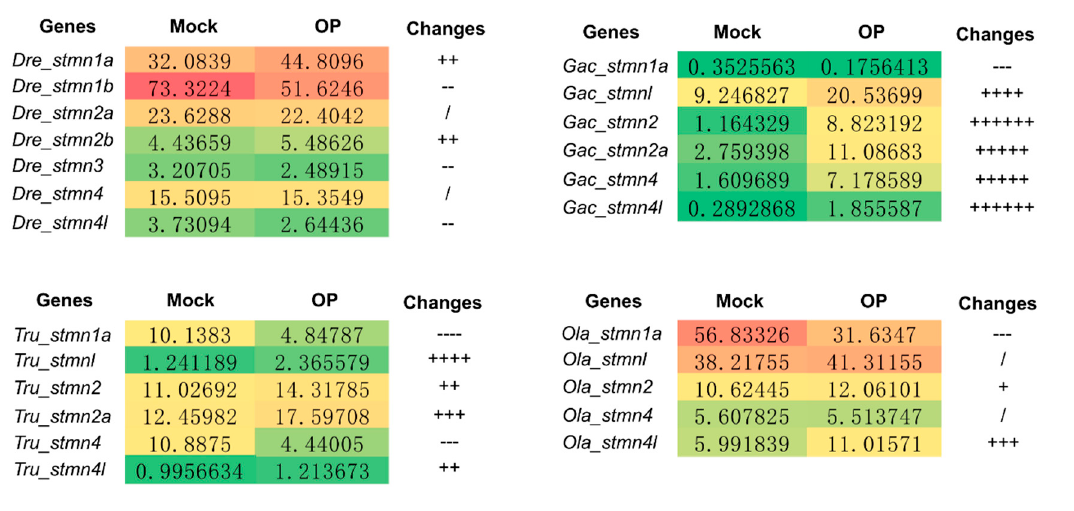
Table S1: Stathmin genes identified in this study, Figure S1: Phylogenetic tree of 27 species of fish based on 16S rDNA sequences. Fruitfly was used as an outgroup, Figure S2: Phylogenetic relationships of the stathmin genes in 27 species of fish. ML phylogenetic tree was constructed and four groups (STMN1, STMN2, STMN3, and STMN4) were classified here. Dme_stmn gene (FBgn0266521) of fruitfly was used as an